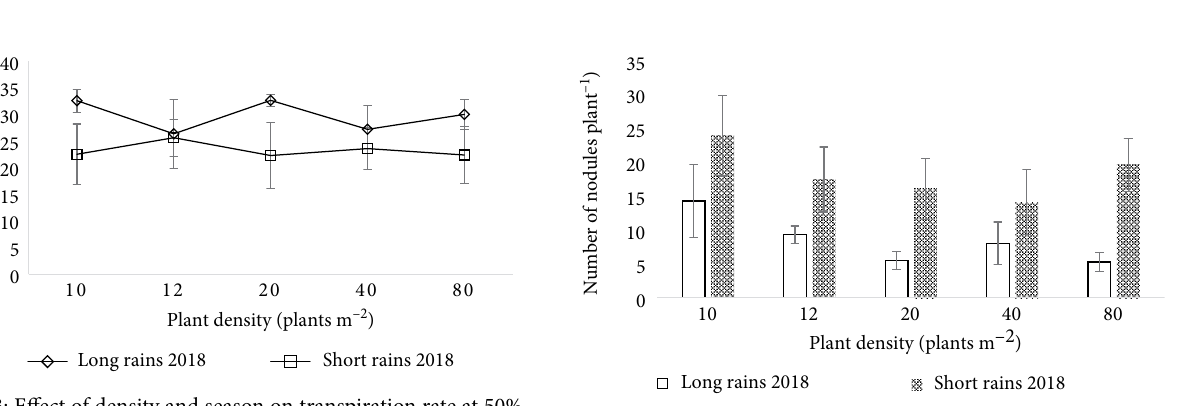
HSD = Tukey’s honestly significant difference; CV = Coefficient of variation.